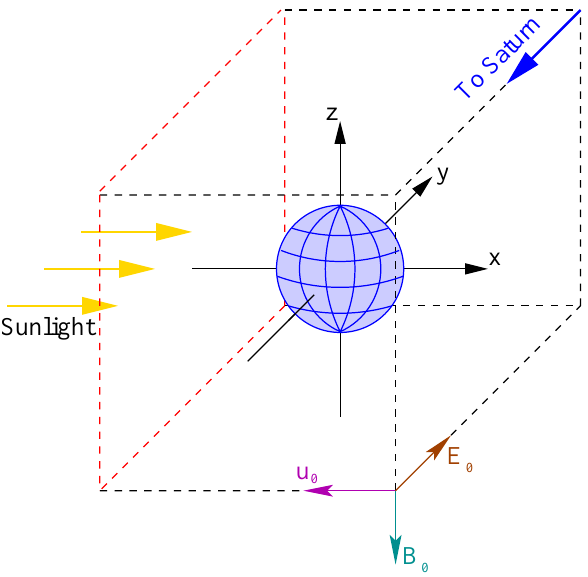
Fig. 13. Titan’s plasma environment at 06:00 Saturnian local time – simulation geometry. The center of Titan coincides with the cen- ter of the cubic simulation domain. Again, the positive x axis is parallel to the direction of the solar UV radiation, whereas the undisturbed Saturnian magnetic field is orientated antiparallel to the z axis. Hence, the velocity vector of the undisturbed corotating plasma flow is directed antiparallel to the x axis. The convective electric field points in ( + y) direction, i.e. away from Saturn. The (x,y) plane of the coordinate system coincides with Titan’s equa- torial plane; the terminator line is located in the (y,z)